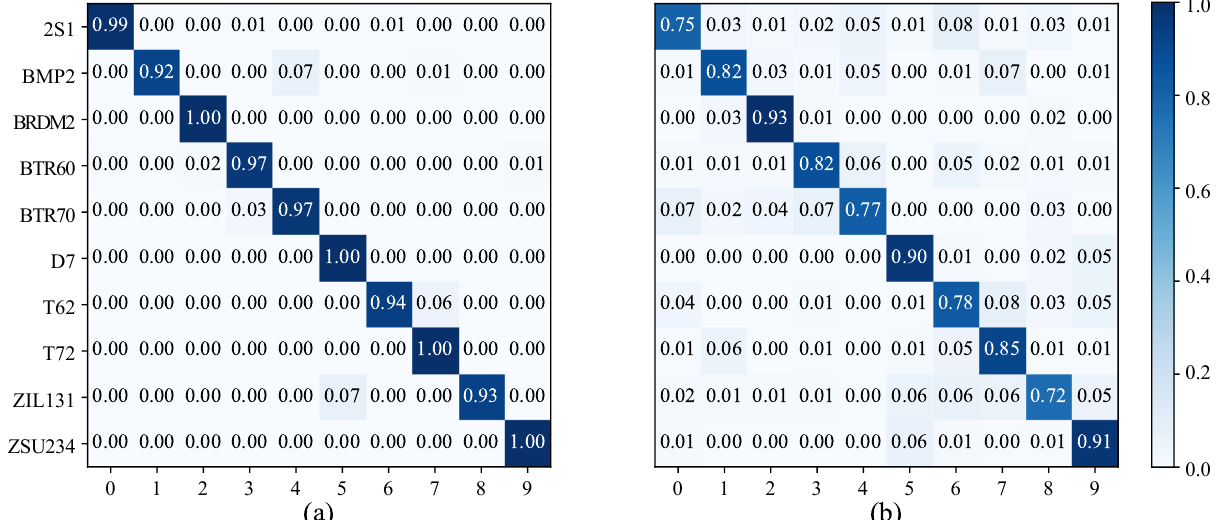
Figure 4. Confusion matrices of the proposed method and the corresponding supervised method under 10 labeled samples per category: ( a ) MBM; ( b ) supervised method.